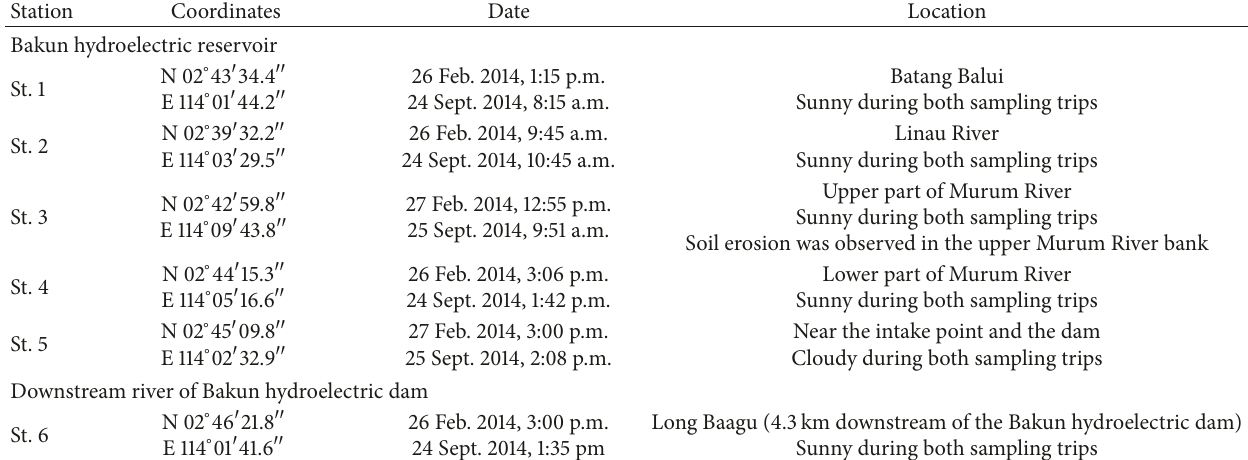
Table 1: The details of the sampling location and sampling regime in the present